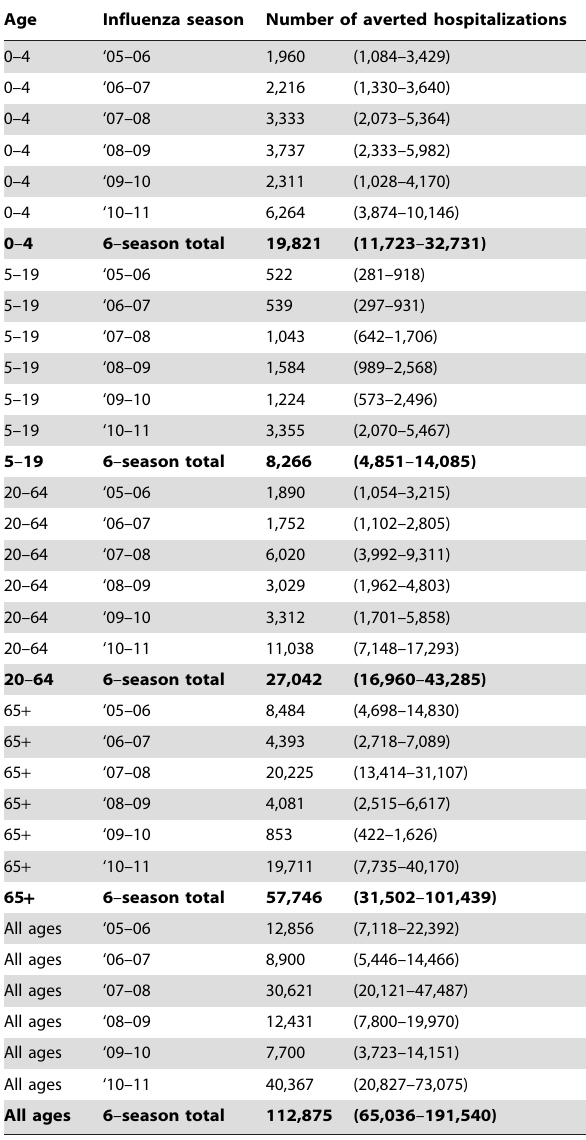
Table 4. Estimated number of influenza hospitalizations averted by vaccination, 2005/06–2010/11 influenza seasons (95% confidence interval in